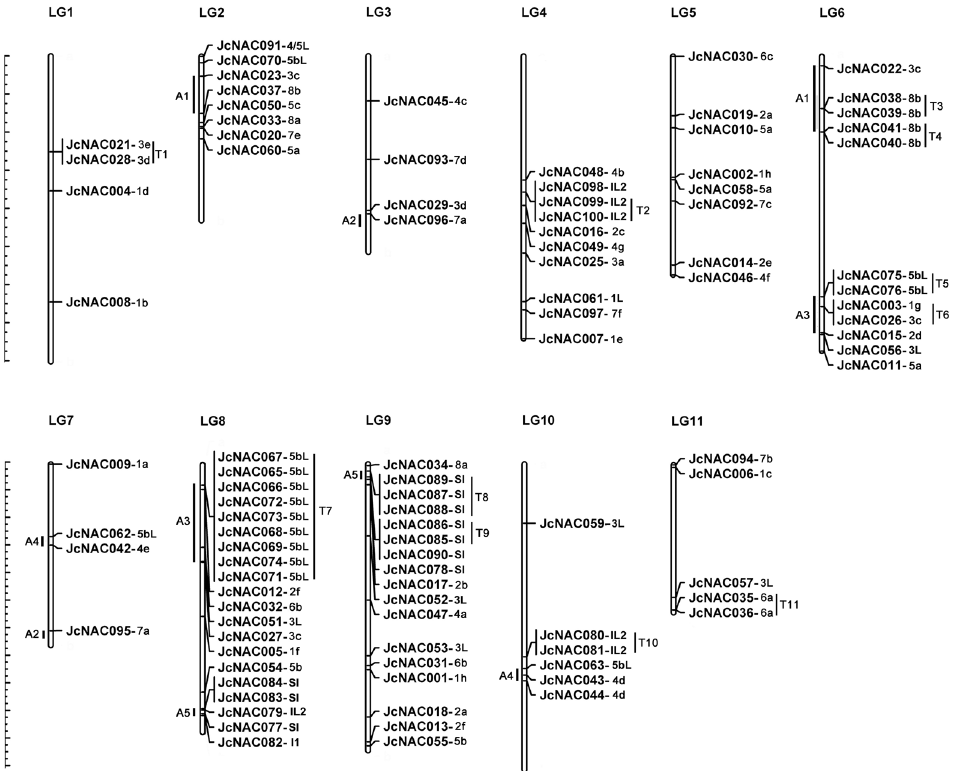
Fig 2. Chromosomal localization of physic nut NAC genes. Chromosomal localization of JcNAC genes based on the linkage map. In total, 98 JcNAC genes were mapped to the 11 linkage groups (LGs). The scale is in centimorgan. T, tandem duplication; A, ancient segmental duplication based on the genome synteny [26].